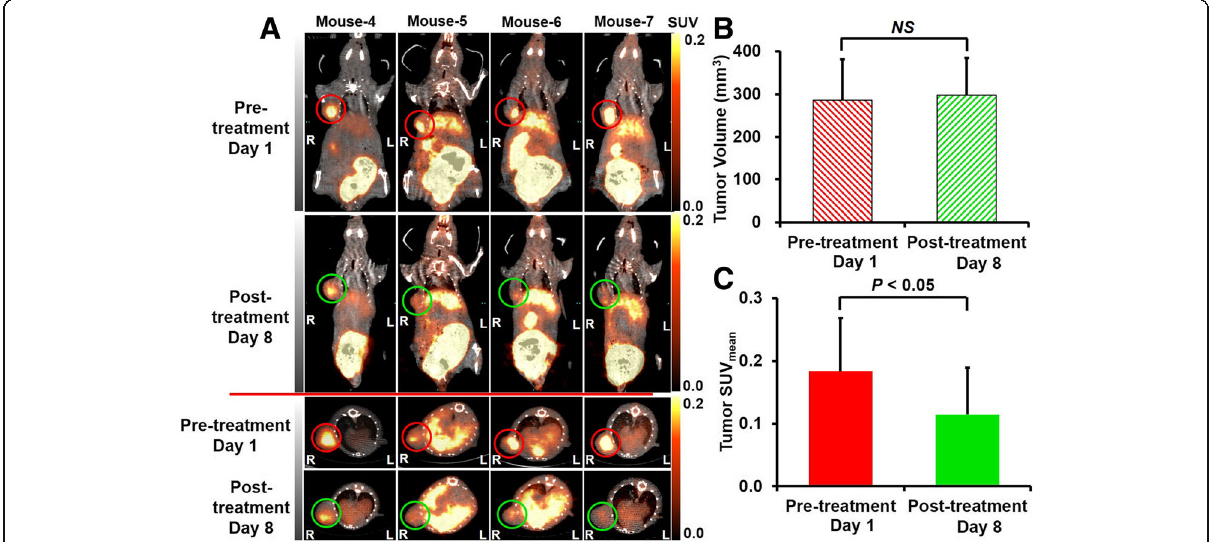
Fig. 6 18 F-FMISO PET images ( a ), tumor volumes ( b ), and quantitative analyses of tumor mean SUV (SUV mean ) ( c ) in mice treated with eribulin in PET imaging study